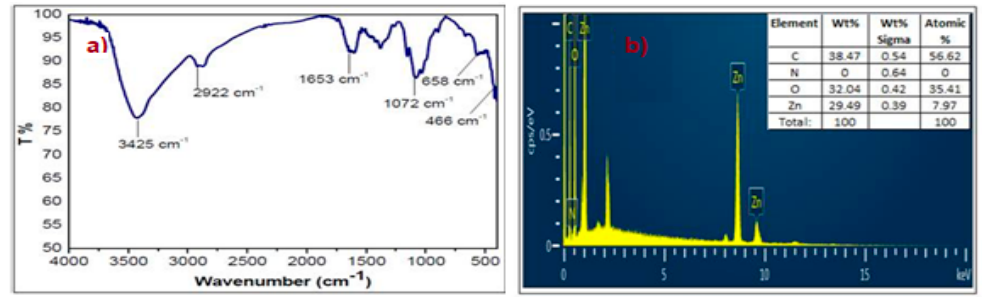
Figure 2. ( a ) FTIR spectra; ( b ) EDX pattern of Chitosan ‐ ZnO NPs.